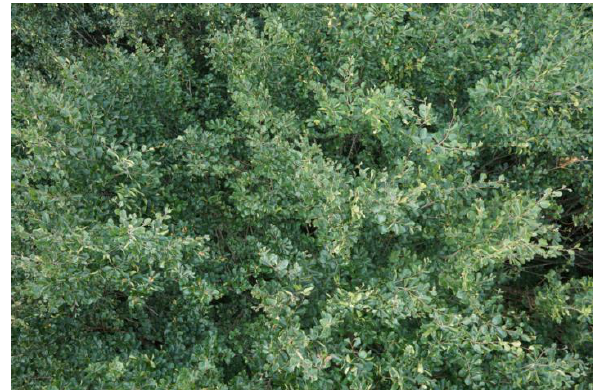
Figure 3. RGB image captured from the experimental crane.